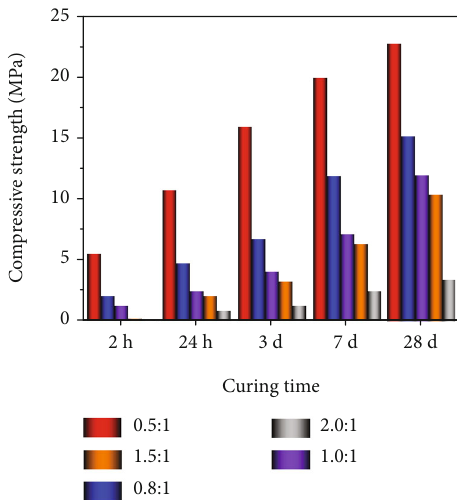
Figure 1: Relationship between water-cement ratio and compressive strength of slurry stone.